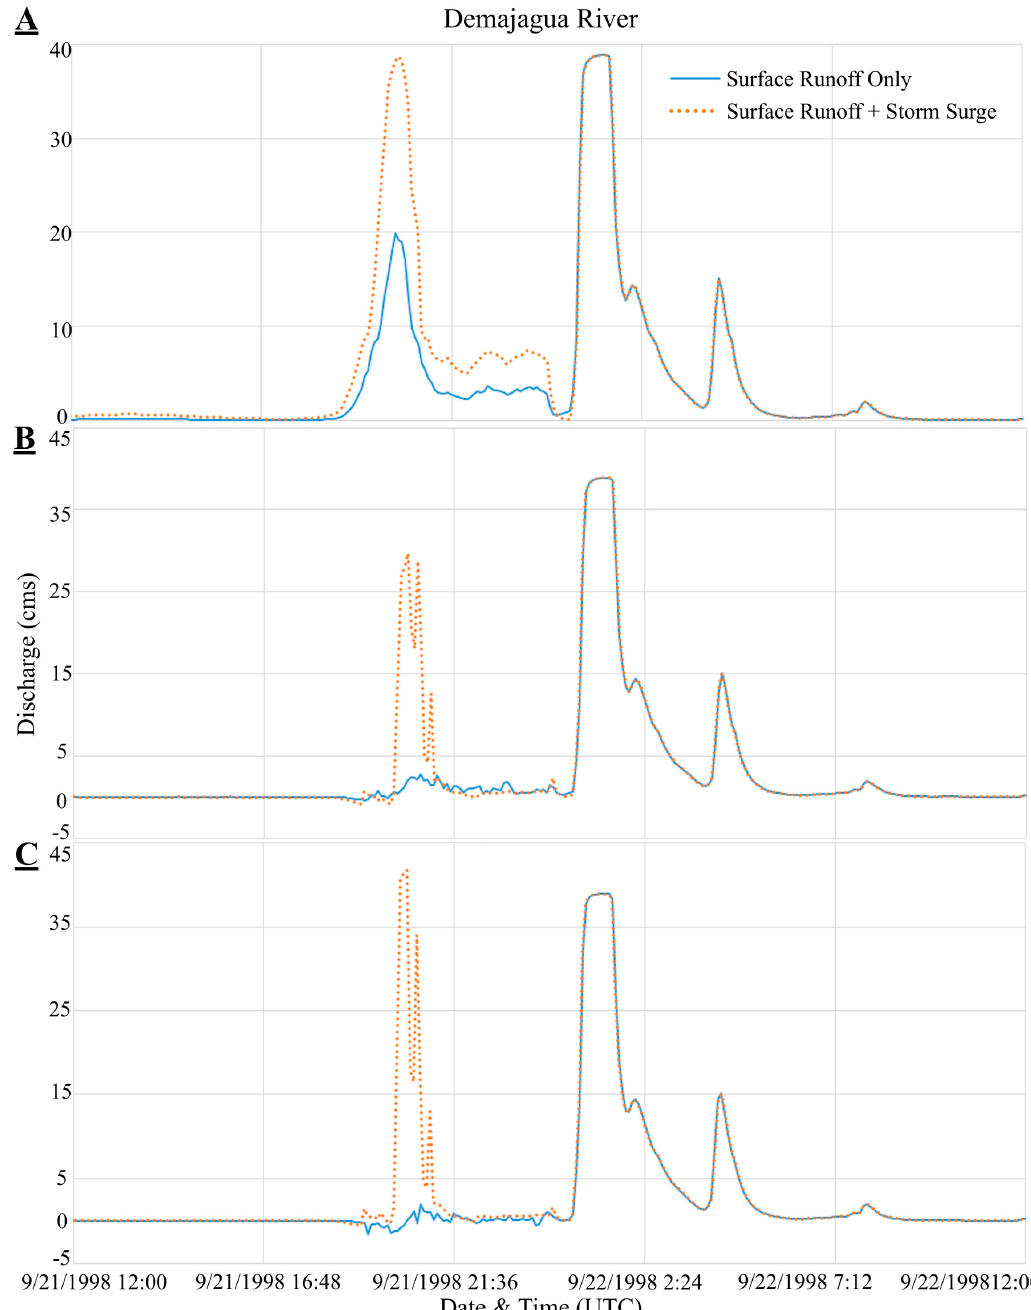
Figure 14. Discharge hydrograph for the different flooding scenario and at different locations for the Demajagua River watershed. ( A ) At 0-m from the stream outlet; ( B ) At 50-m from the stream outlet; ( C ) At 100-m from the stream outlet. The “Surface Runoff + Storm Surge” flooding scenario is represented with orange dots line and the “Surface Runoff Only” flooding scenario is represented with a solid blue line. The discharge is expressed in cubic meters per second (cms).